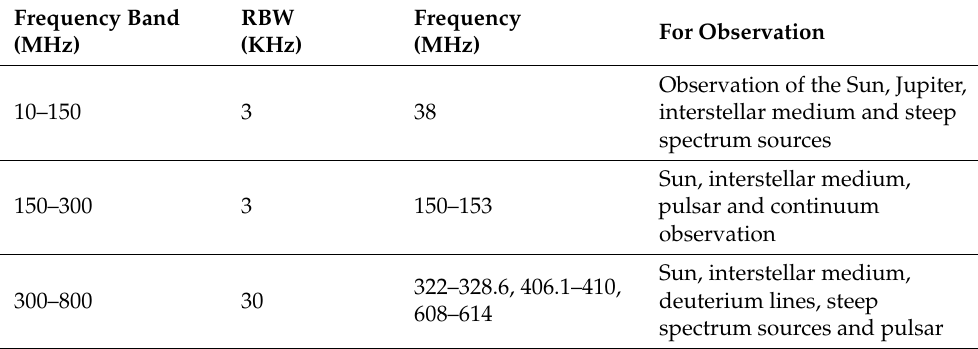
Table 1. Measurement cycle specified by the SKA protocol, for Mode 1 [adapted from 9,10]. RBW: minimum resolution bandwidth in KHz units.